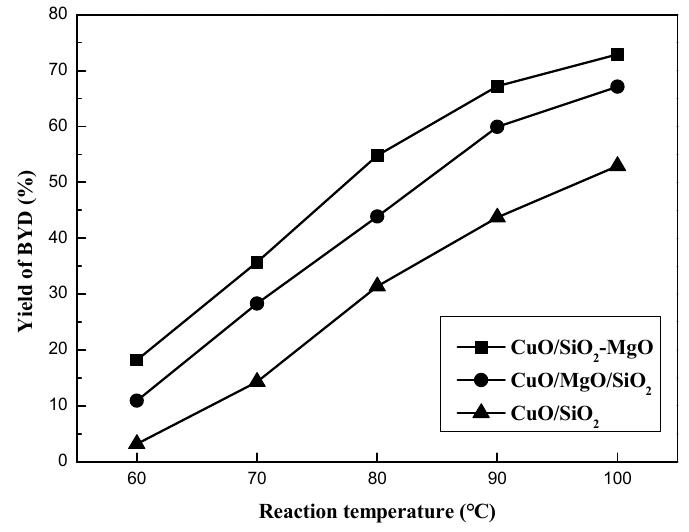
Figure 13. E ff ect of reaction temperature on the yield of Figure 13. Effect of reaction temperature on the yield of BD.